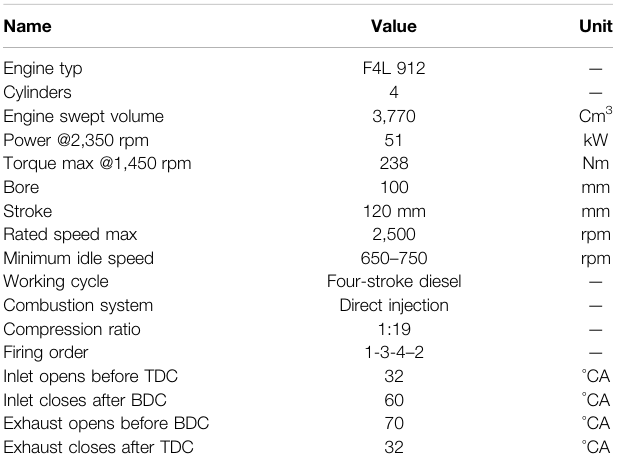
TABLE 1 | Engine parameters. TABLE 2 |